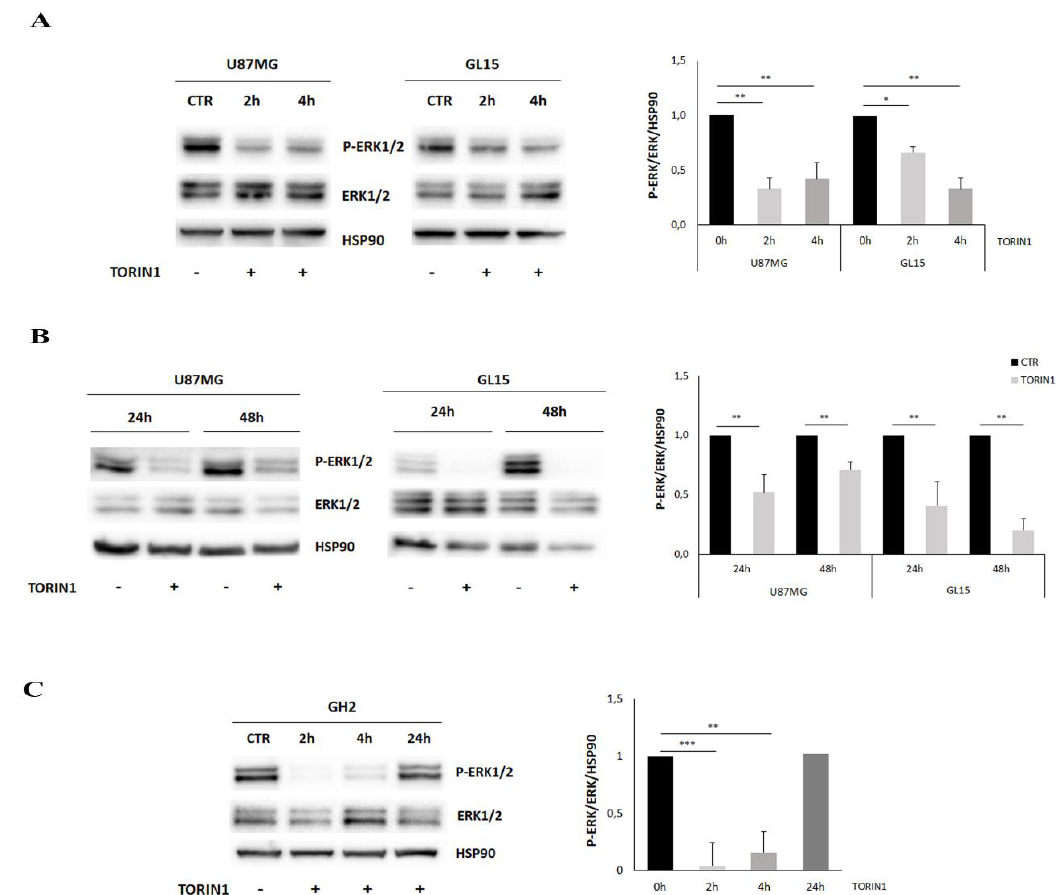
Figure 5. The mitogen activated protein (MAPK)/ERK pathway is down-regulated upon mTOR inhibition in GBM cells. ( A , B ) U87MG, GL15 were cultured in complete DMEM medium in the presence (TORIN1) or absence (CTR) of 250 nM Torin1 and analysed at 2 h and 4 h ( A ) and at 24 h and 48 h ( B ). Western blot analysis was performed by using specific antibodies for ERK1/2 and P-ERK1/2. HSP90 was used as loading control. ( C ) GH2 cells were cultured in complete DMEM medium in the presence (TORIN1) or absence (CTR) of 250 nM Torin1 and analysed at the indicated time points. Western blot analysis was performed by using specific antibodies for ERK1/2 and P-ERK1/2. HSP90 was used as loading control. The graph represents the mean ± SD of three different experiments.